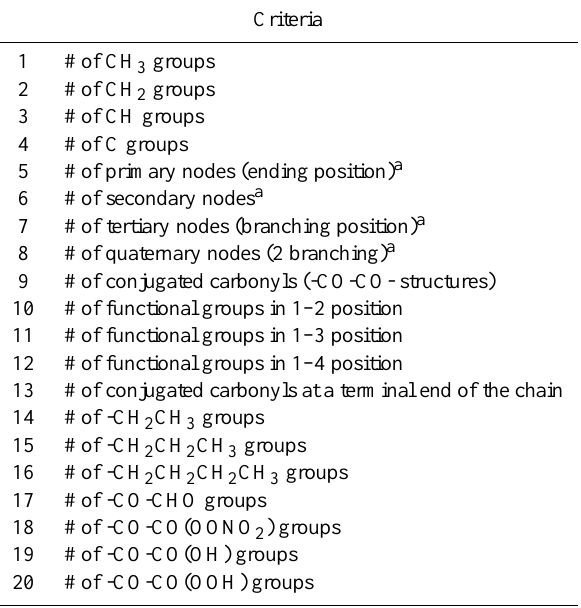
Table 1. Criteria used in the reduction protocol using surrogate species for position isomer (see